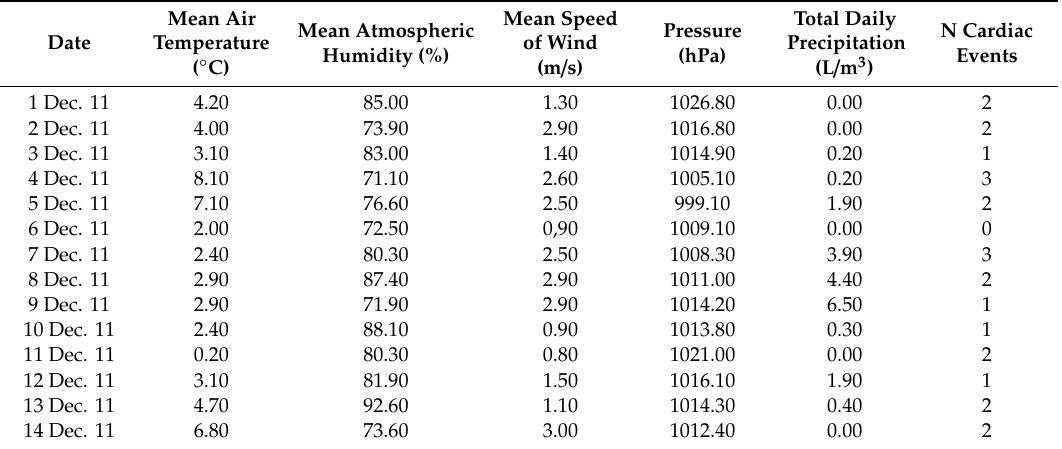
Table9. ExamplerowsoftimeseriesdatafromtheTarn ó wdatasetshowingdailylevelsofenvironmental variables and daily number of cardiac